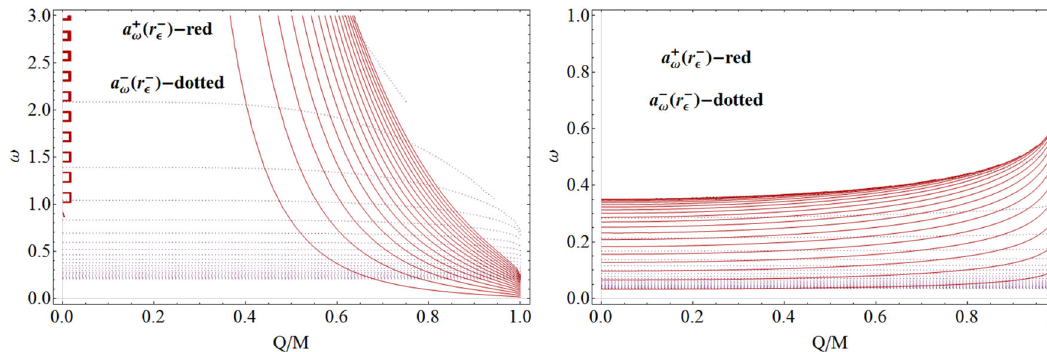
Fig. 23 Spins a ± ω = constant on the static limits r ± (cid:9) on the equatorial plane